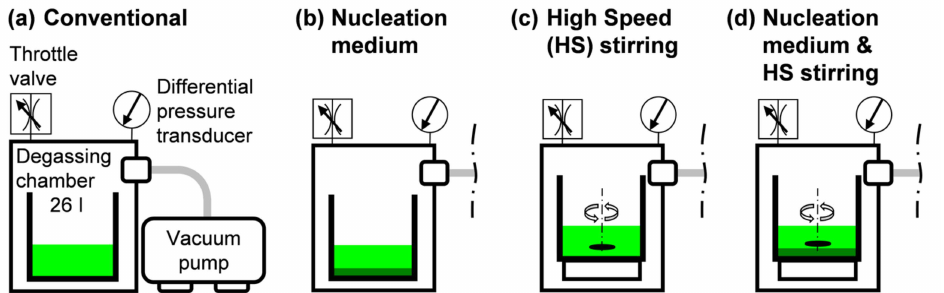
Figure 2. Vacuum degassing configurations: ( a ) Conventional vacuum degassing without additional assistance; ( b ) Assisted by adding a nucleation medium; ( c ) Assisted by high speed resin stirring; ( d ) Assisted by adding a nucleation medium and high speed resin stirring. Preforms were enclosed in an ordinary assembly with peel-ply layers covering preform top and bottom surfaces (Figure 3). Inlet and venting channels were placed parallel to preform edges ( z direction) to force a rectilinear flow front progression and in-plane preform impregnation ( x direction). No separation was allowed between channels and preform edges to avoid unnecessary flow resistance; since it is a proven cause of pressure equalization into the preform [19].